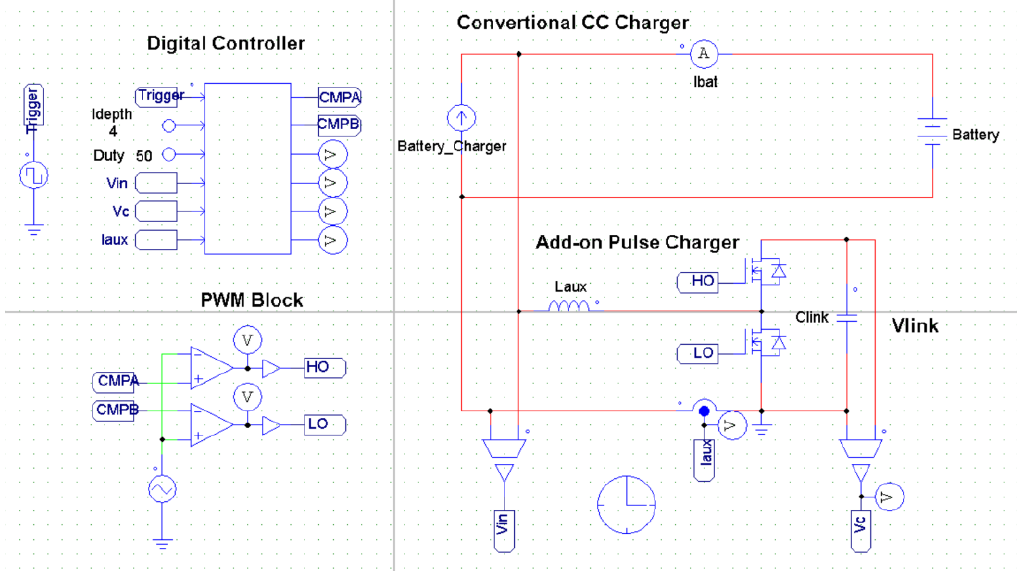
Figure 9. Circuit of the simulation.